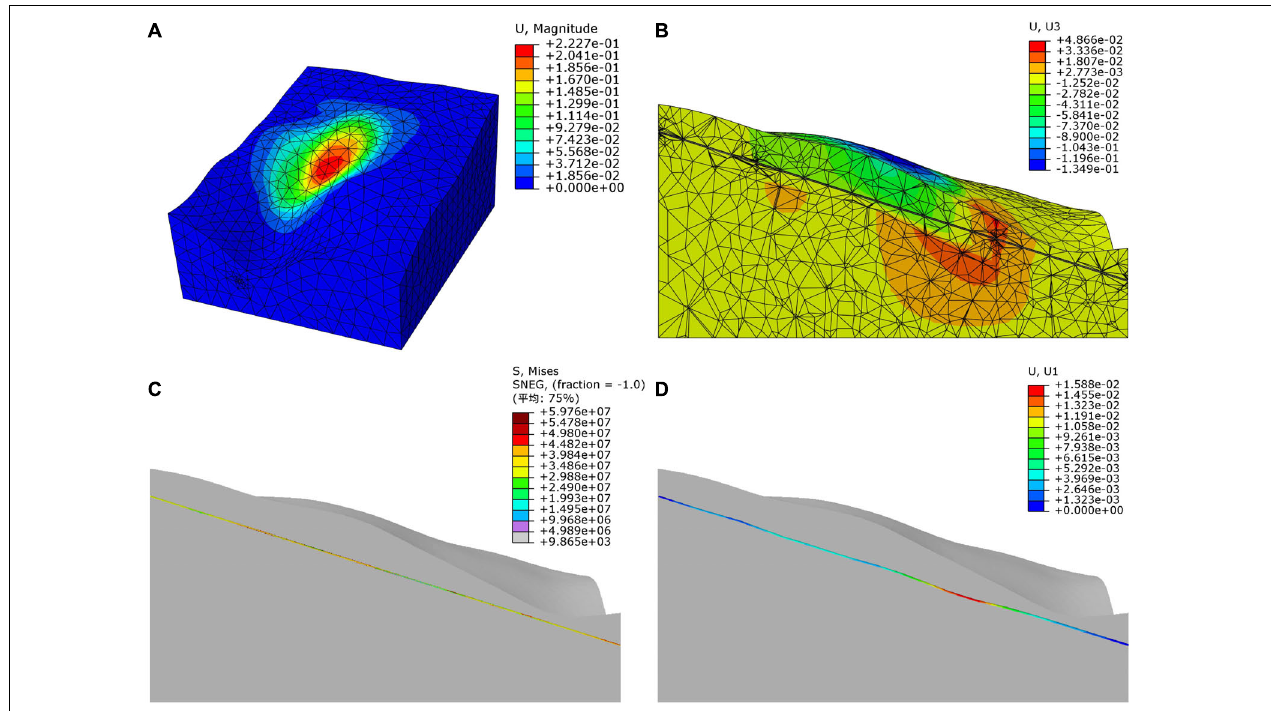
FIGURE 12 | Slope displacement, pipeline Mises’s stress, and pipeline displacement under accelerated sliding conditions. (A) Slope displacement, (B) Slope vertical displacement along the pipe section, (C) Pipe Mises stress, and (D) Along an unstable slope deformation of the pipe in the direction of movement ( x direction).